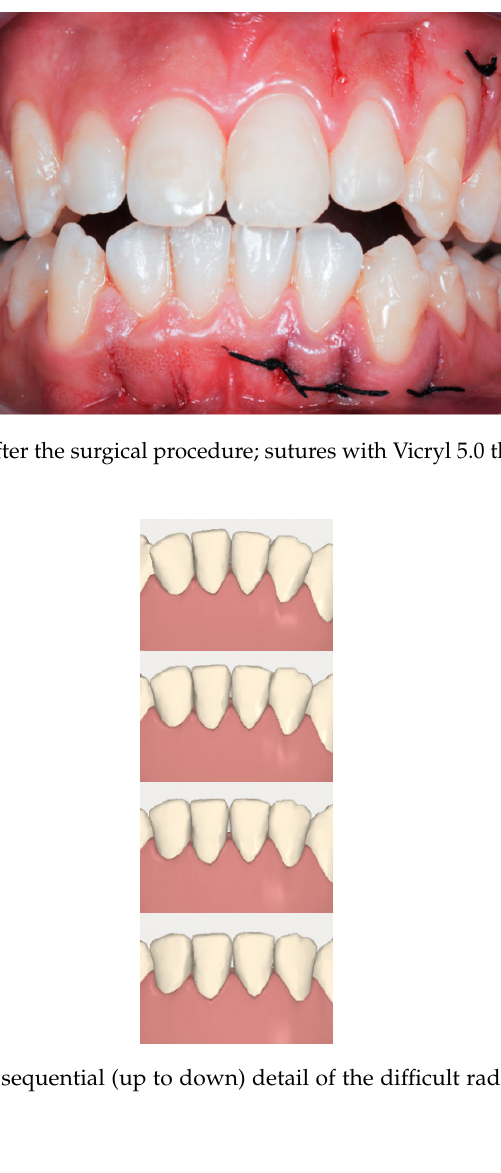
Figure 8. Case 1: modified piezocision corticotomy detail.